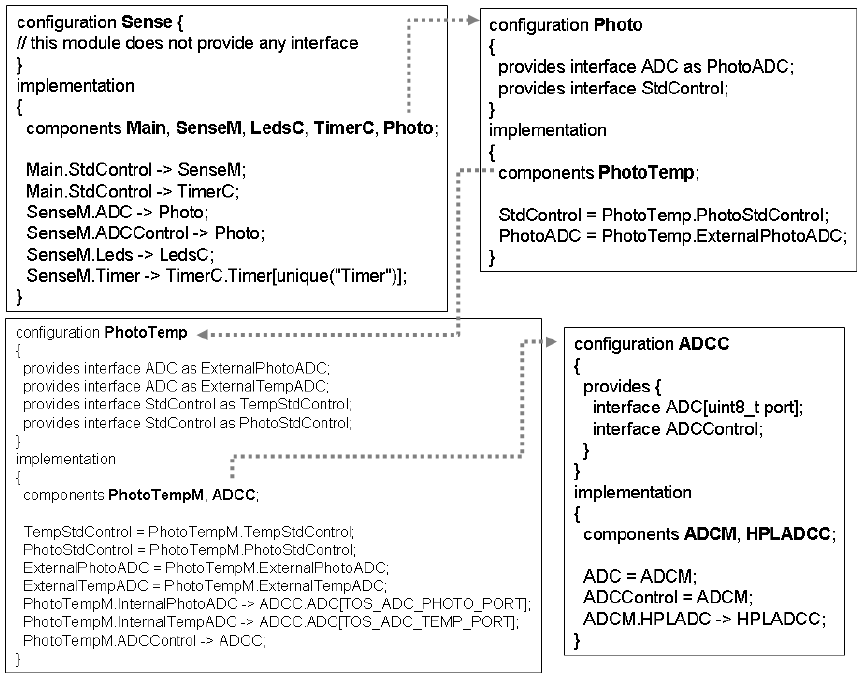
Figure 4 . nesC Sense